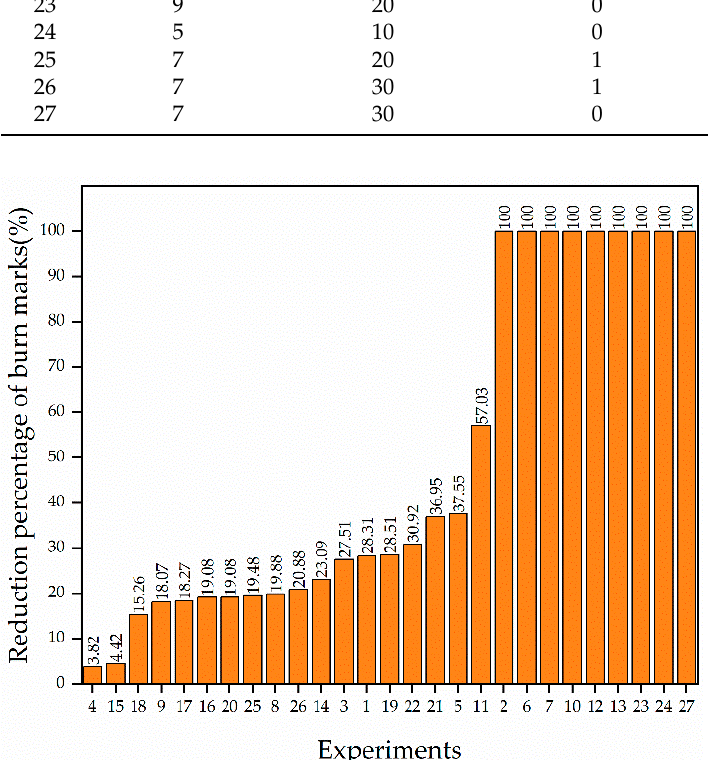
Figure 5. Reduction percentage of burn marks in parts molded by EGAIM. In one third of the experiments, the burn marks were completely invisible on the molded part. The burn marks were eliminated by EGAIM with the given gas parameters in those experiments. More than half of the experiments show reduction percentages from 15 to 40%, and the lowest reduction percentage is about 4%, appearing in only two experiments. The burn marks were reduced to a certain degree by